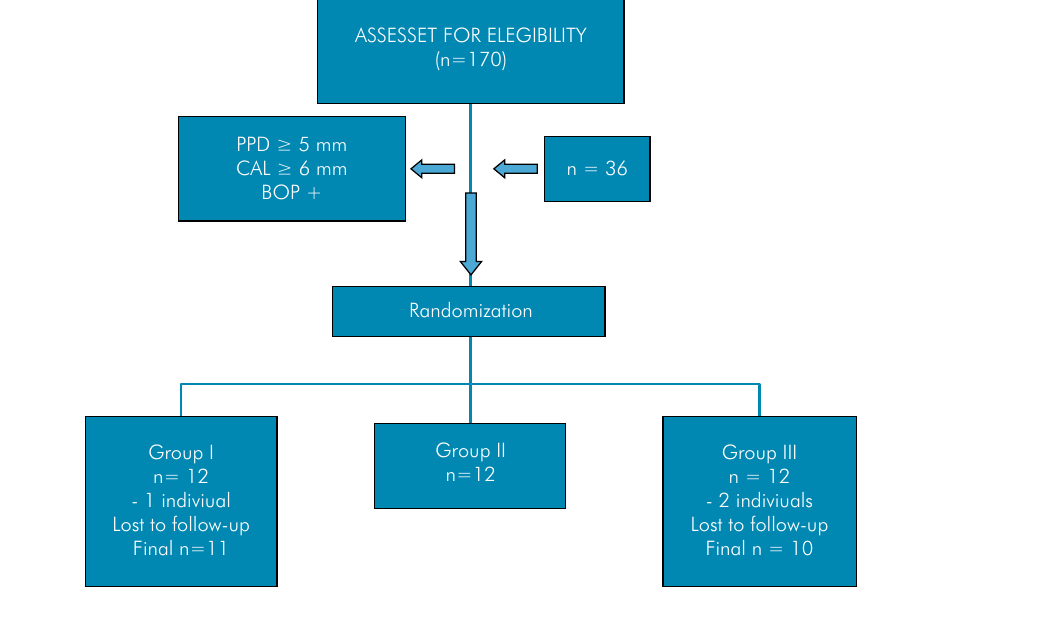
Figure 1. Flow chart of the